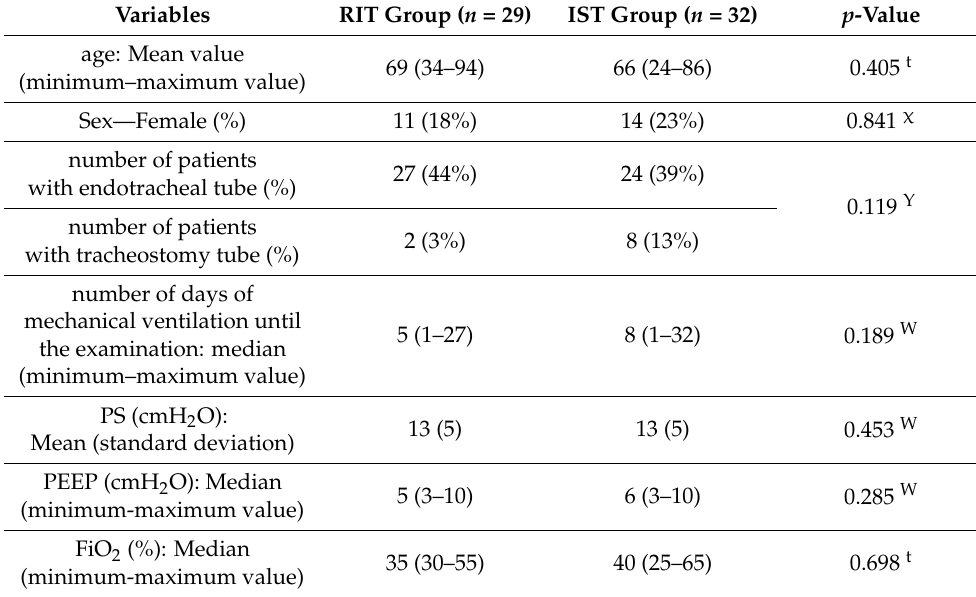
Table 1. The general characteristic of the patients.